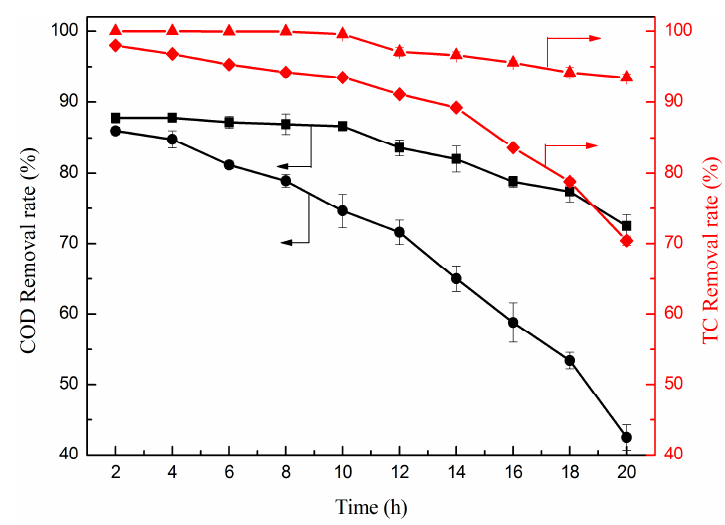
Figure 9. TC removal rate by the TiO 2 /carbon membrane ( ▲ ) and the original carbon membrane ( ◆ ); and COD removal rate by the TiO 2 /carbon membrane ( ■ ) and the original carbon membrane ( ● ) versus operation time. ( RT = 4.4 min, T = 25 °C, and j = 1 mA·cm − 2 ).